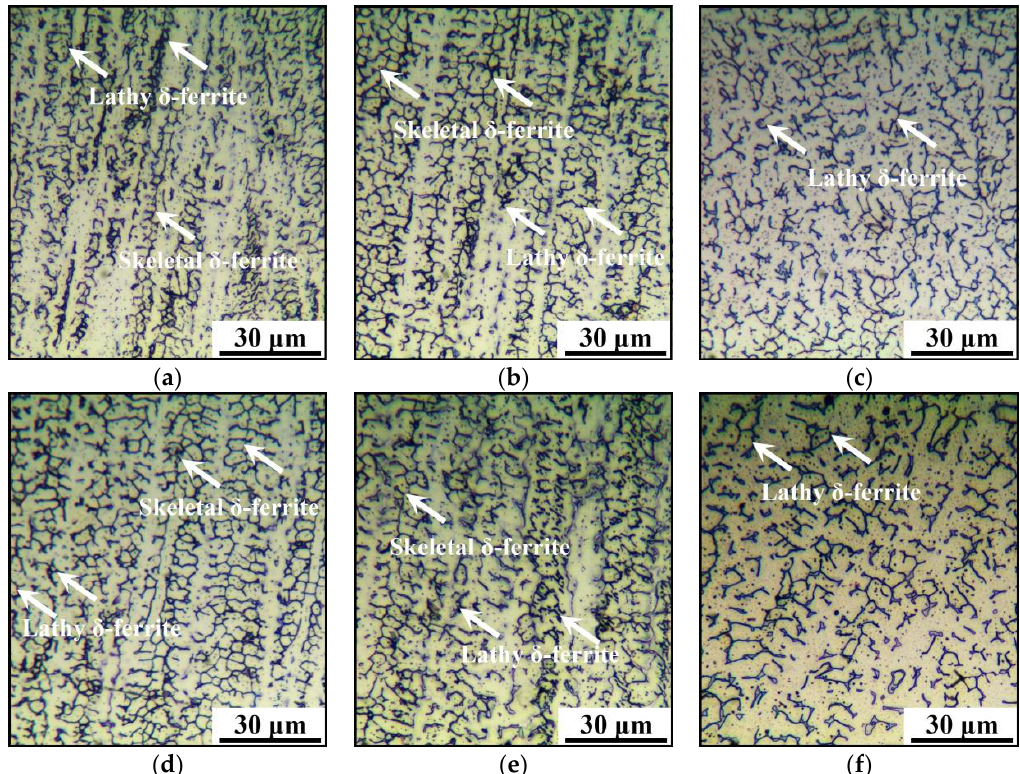
Figure 6. Microstructures of the AM parts with: ( a ) low LEI and high CR; ( b ) low LEI and medium CR; ( c ) low LEI and low CR; ( d ) high LEI and high CR; ( e ) high LEI and medium CR; ( f ) high LEI and low CR. Table 3. δ-ferrite contents and primary dendrites spacing of the AM parts under different LEIs and CRs. Microstructure Characteristics